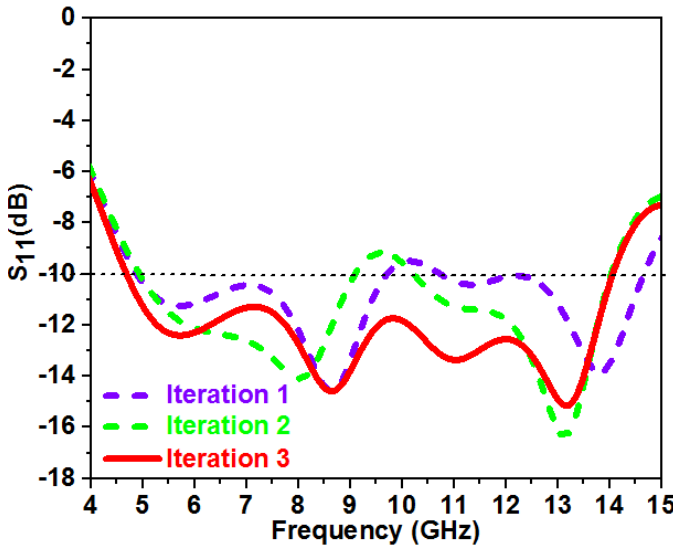
Figure 5. S 11 features of the evolution stages.